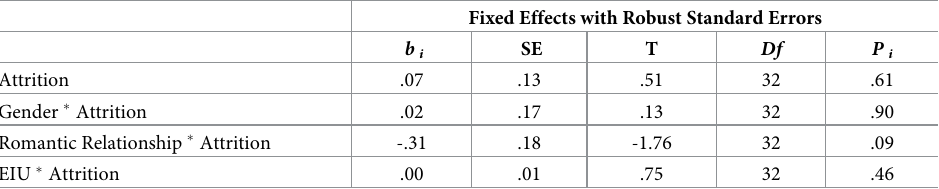
Table 2. Assessment of the attrition effects in HLM analyses.